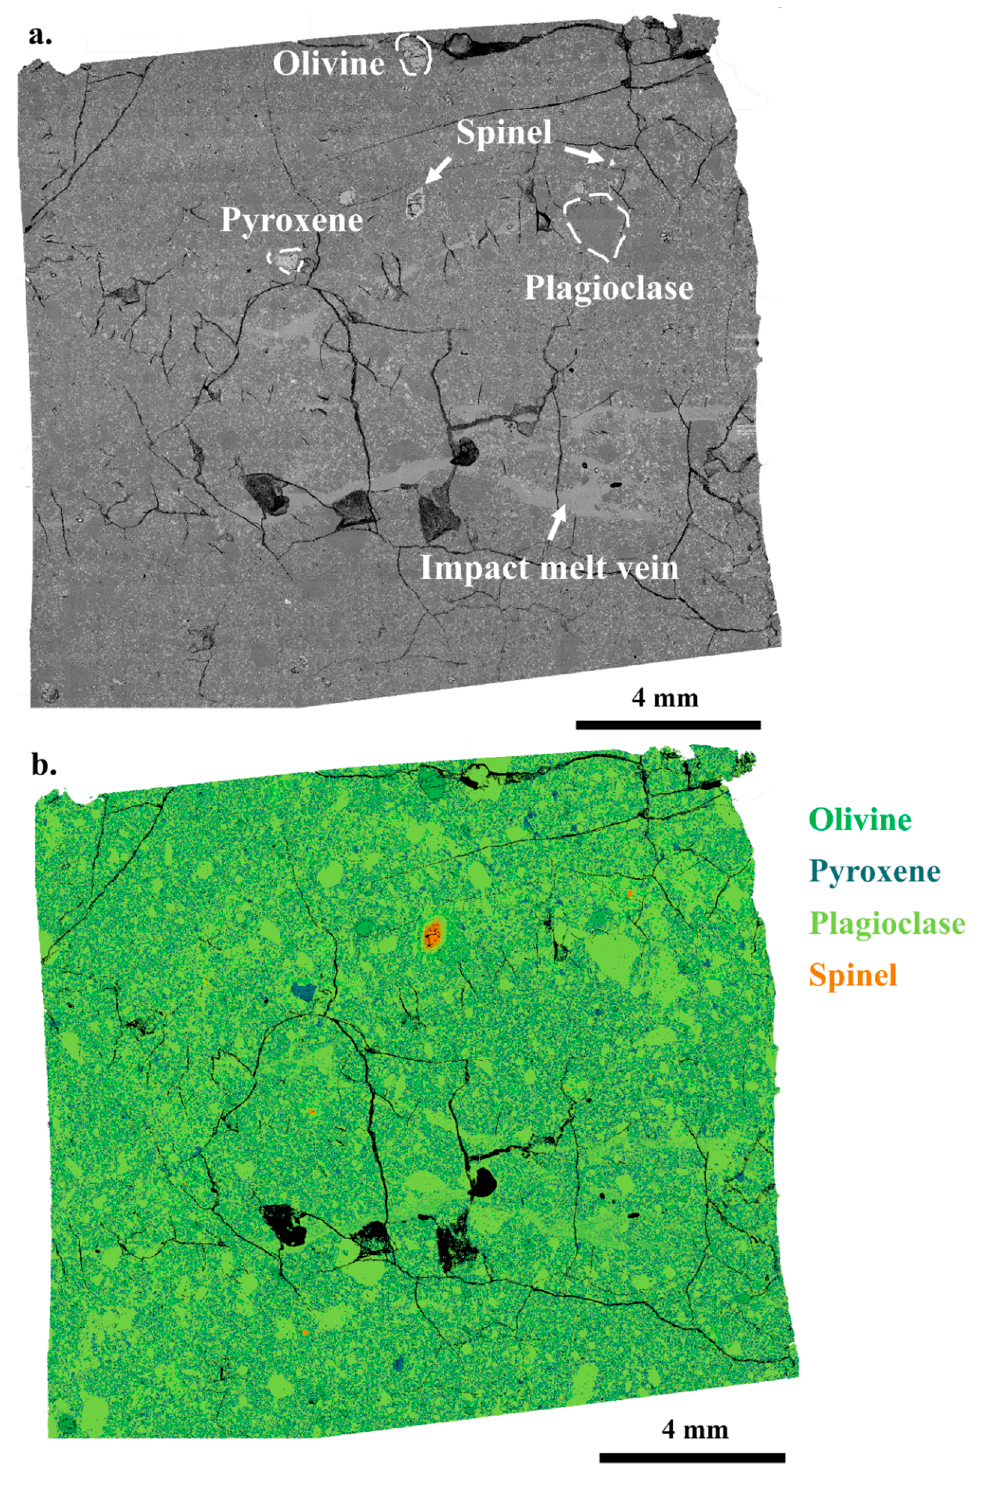
Figure 3. ( a ) backscattered electron (BSE) image of a polished section of NWA 8687. ( b ) Distribution of main minerals in NWA 8687 based on X-ray element maps.